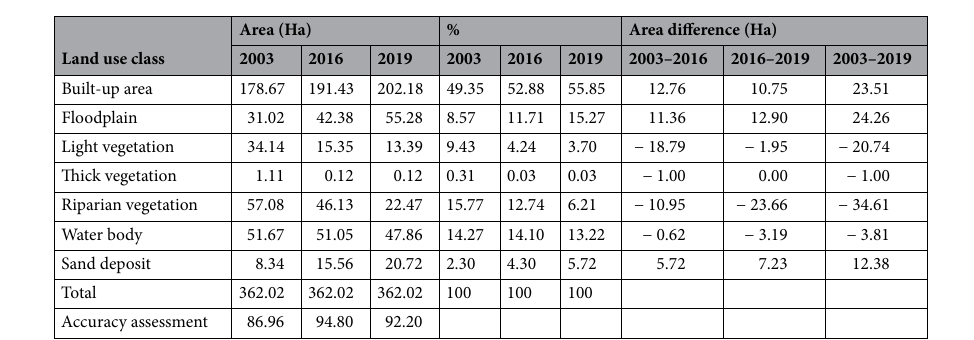
Table 4. Land use/land cover change in the Reach 3 area from 2003 to